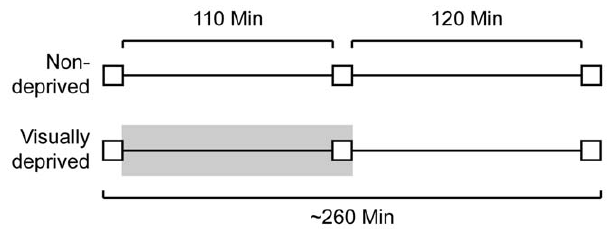
Figure 6. Experiment 3 conditions. A non-deprived group and a visually deprived group of participants were tested three times on the GOT (white squares). A 110-minute conversation period separated the first and second tests, and a 120-minute break separated the second and third tests. The shaded rectangle indicates the period of visual deprivation. The experiment duration was approximately 260